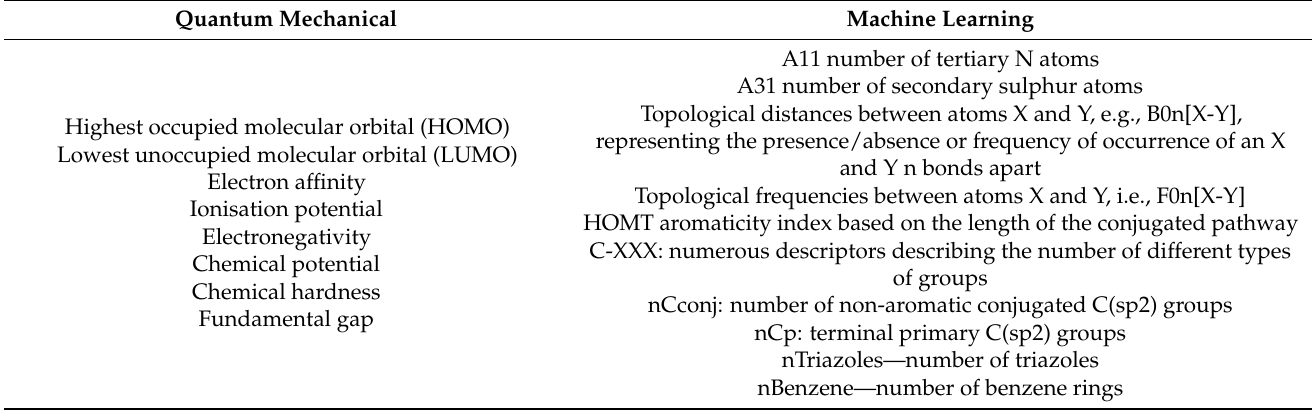
Table 2. Typical molecular descriptors for quantum mechanical and machine learning